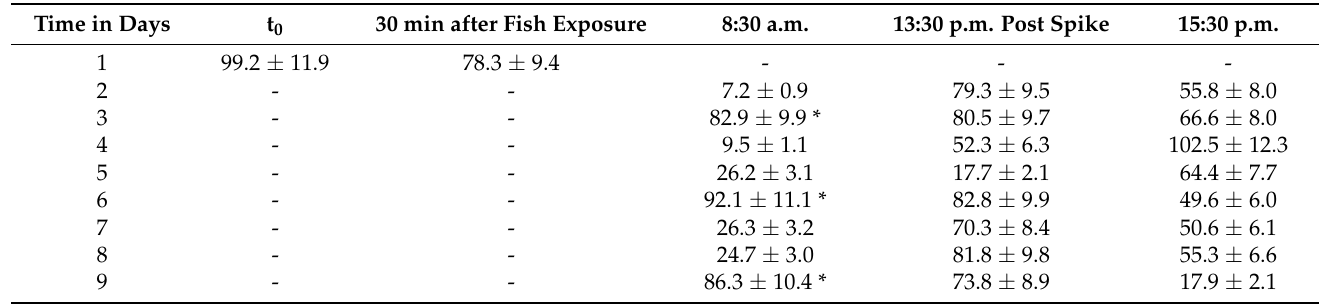
Table 2. Actual BP-3 concentrations measured in water with fish after spiking with a nominal concentration of 100 µ